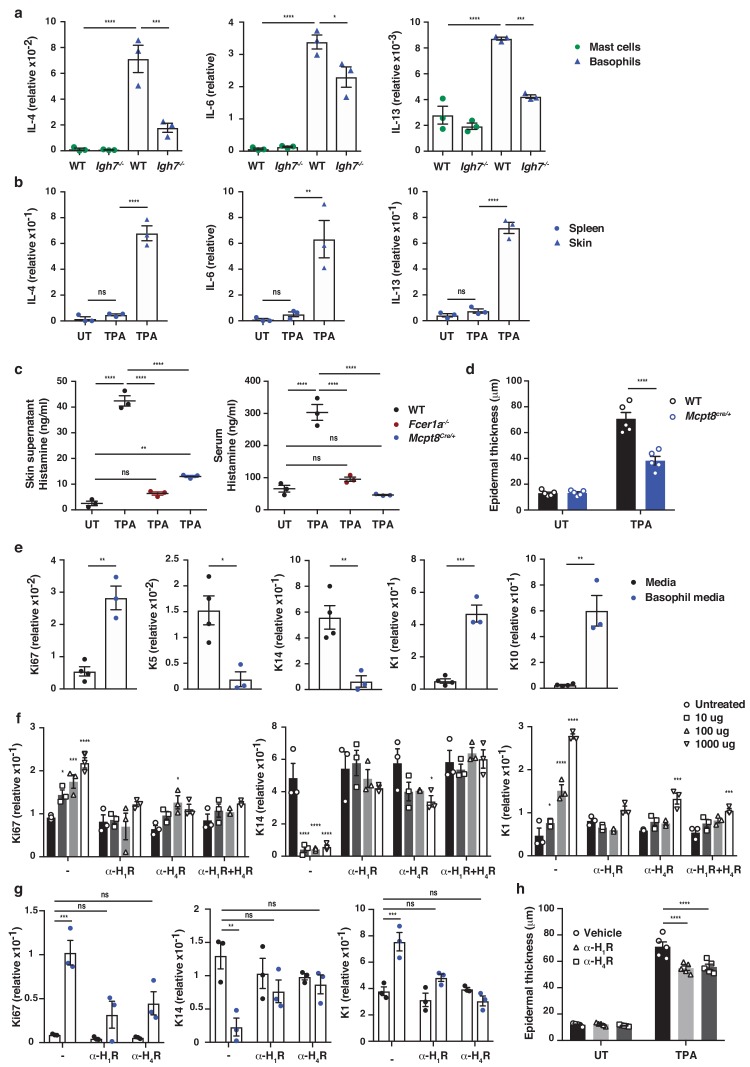
IgE activity in inflamed skin is mediated via FcεRI-signalling in basophils.(a–d, h) Healthy untreated (UT) ear skin of mice was examined and compared to inflamed TPA-treated skin (topical TPA 2x/week for 2 weeks). (a) Mast cells and basophils were FACS sorted from the skin of WT and Igh7–/– mice and (b) basophils were sorted from the spleen of WT mice 72 hr after the last TPA treatment (n = 3/group). Mast cells were defined as CD45hicKit+FcεRI+CD41– and basophils as CD45locKit–FcεRI+CD41+. (a, b) Quantitative RT-PCR analysis of the levels of Il4, Il6 and Il13 transcripts in the FACS-sorted cell populations from the indicated tissues relative to levels of the control gene cyclophilin. (c) ELISA assessing the amount of histamine released ex vivo from ear skin into media when floated overnight (left panel) and in vivo into the serum (right panel) of WT, FceR1a–/– and Mcpt8Cre/+ mice (n = 3/group). (d) Epidermal thickness measured from H&E-stained cross-sections of WT and Mcpt8Cre/+ ear skin (n = 5/group). (e–g) Neonatal WT skin EC (keratinocytes) were grown in vitro to 70% confluency and then supplemented with (e) media from IgE-crosslinked basophils or media alone or (f) differing concentrations of histamine (n = 3/group). Histamine receptors on ECs were blocked by adding 10 μM H1R- or H4R-antagonist or both to cultures with added histamine (f) or basophil media (g) (n = 3/group). (e–g) EC were analysed by qRT-PCR for the expression levels of transcripts indicating cell cycling (Ki67) and differentiation (K5, K14, K1 and K10) relative to the expression level of the control gene cyclophilin. (h) Epidermal thickness measured from H&E-stained cross-sections of WT ear skin following in vivo blocking of H1R or H4R by i.p. administration of antagonist drug or vehicle control (n = 5/group). All data are expressed as means ± SEM. Statistical analysis was performed by one-way ANOVA multiple comparison (a–d, f–h) or two-tailed Student’s t-test (e); *p<0.05, **p<0.01, ***p<0.001 and ****p<0.0001. UT = untreated; ns = not significant.